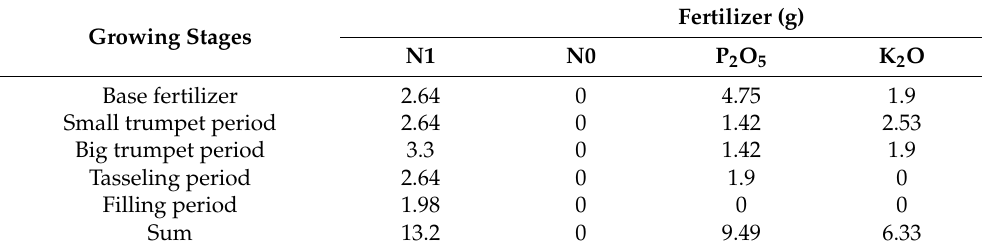
Table 1. Fertilization patterns of maize at different growth